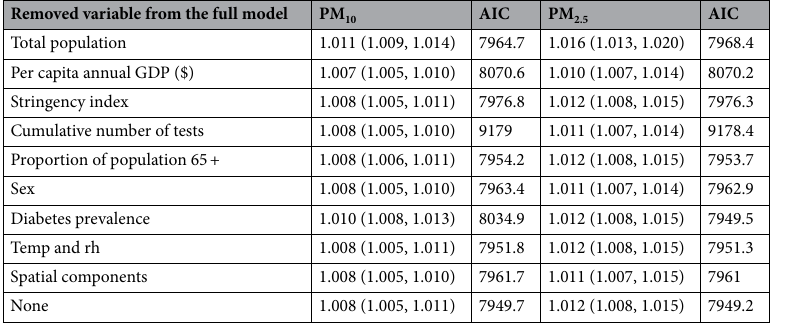
Table 3. Sensitivity analysis: coefficients (exponentiated betas, 95% confidence interval) of associations between main outcome (Covid-19 cumulative number of cases in the 14 days following the date when > 10 cumulative cases were reported) and air pollutants in models adjusted by all but one variable in turn. Temp and rh: temperature and relative humidity in the 30 days before the outcome date; spatial components: cubic splines of distance and bearing. Reported values are the exponentiated betas and 95% confidence